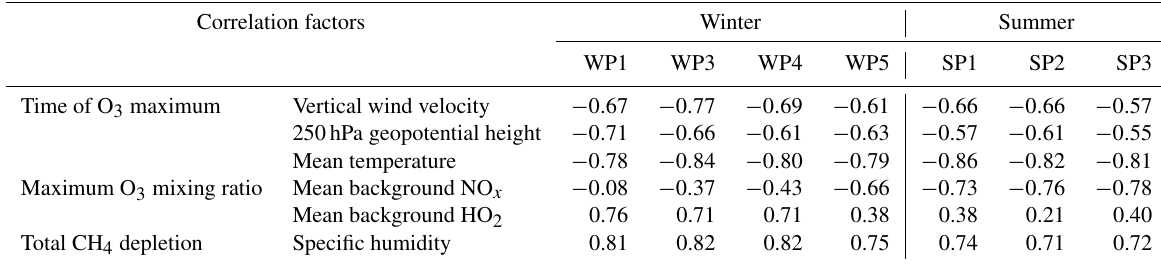
Table 2. Spearman rank coefficients of all identified relations for each individual weather pattern. All correlation factors related to the time and the maximum O 3 mixing ratio are calculated based on mean values for the time span between emission and the time of the O 3 maximum. The correlation between the total CH 4 depletion and specific humidity is based on the mean between time of emission and the time when the total CH 4 depletion is